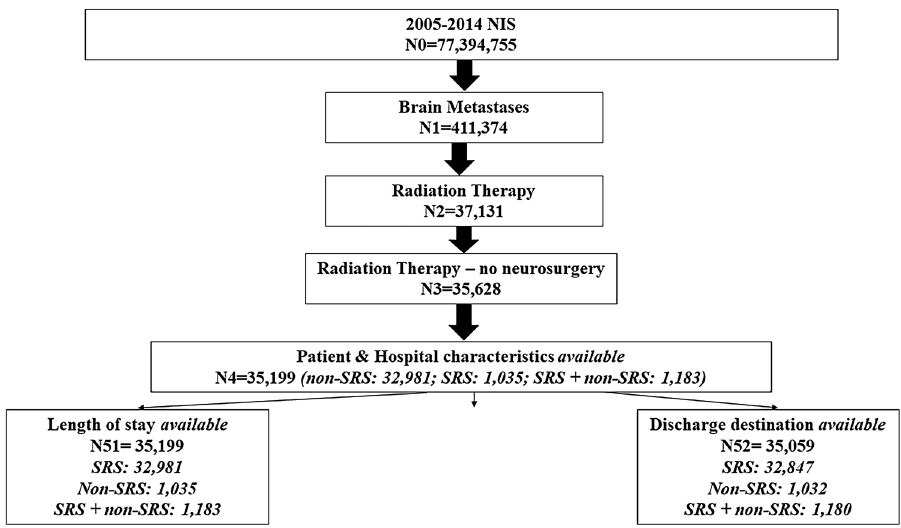
Figure 1. Study flowchart—Nationwide Inpatient Sample